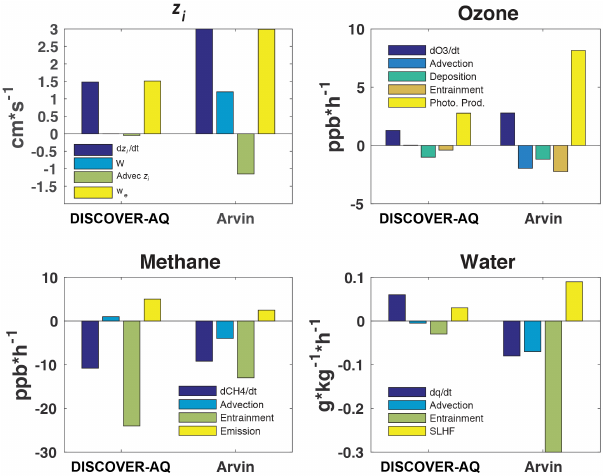
Figure 5. Individual budget terms for each scalar from the flight mission average corresponding to winter (DISCOVER-AQ) and summer (Arvin) in the